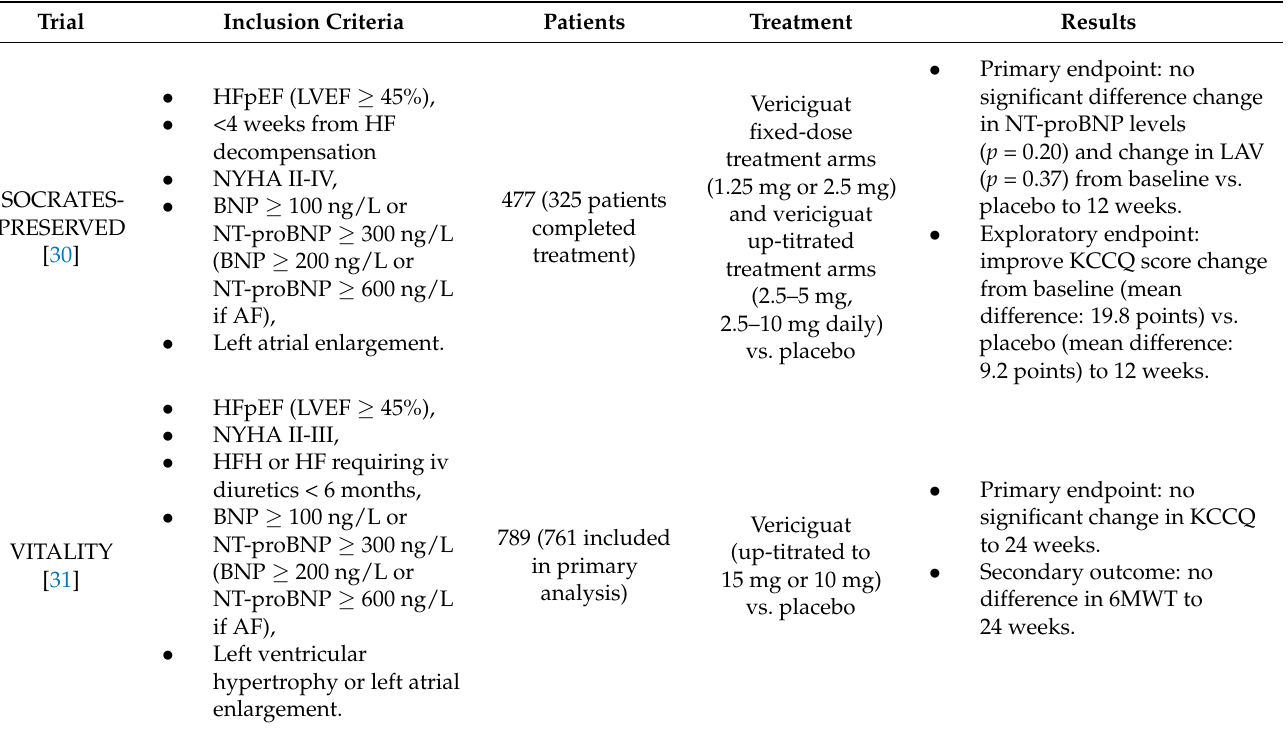
Table 4. Summary of the main results data from the SOCRATES-PRESERVED and VITALITY trials. Trial Inclusion Criteria Patients Treatment